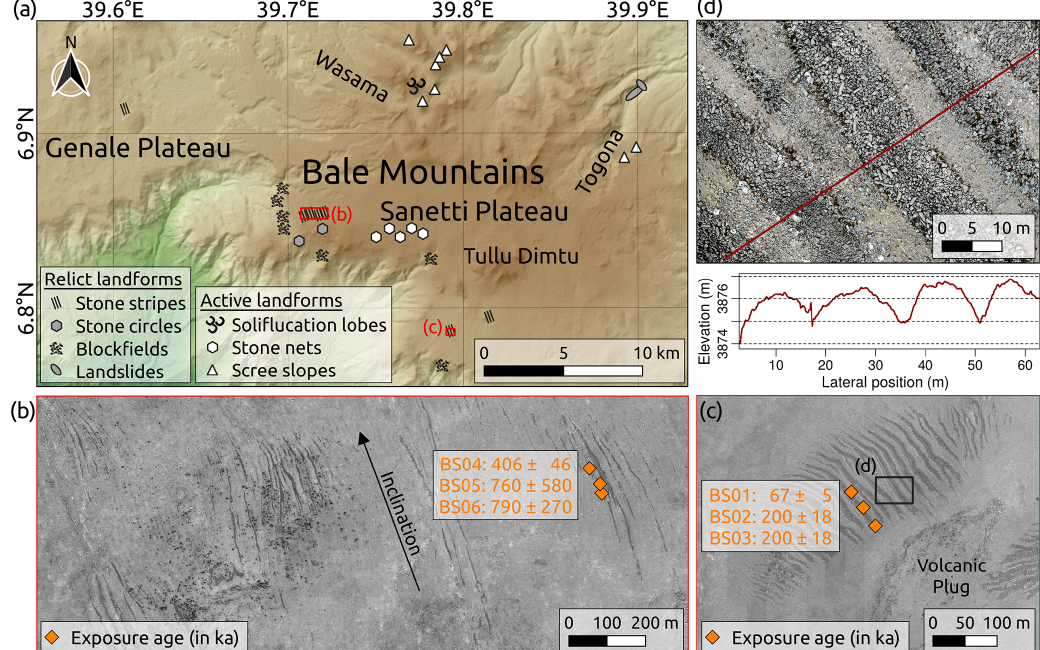
Figure 5. (a) Overview map of relict and active periglacial landforms as well as other characteristic geomorphological features in the Bale Mountains mapped in the field or on high-resolution satellite images. (b) Sorted stone stripes in the western and (c) southern part of the Sanetti Plateau as seen on WorldView-1 satellite images provided by the DigitalGlobe Foundation. The six 36 Cl exposure ages were calculated using the Lifton–Sato–Dunai scaling scheme (Lifton et al., 2014; Marrero et al., 2016), are non-erosion corrected, and given in kiloanni (ka) with total uncertainties (1 σ ). (d) Orthophoto and DSM cross-section profile of the stone stripes derived from the high-resolution UAV data.